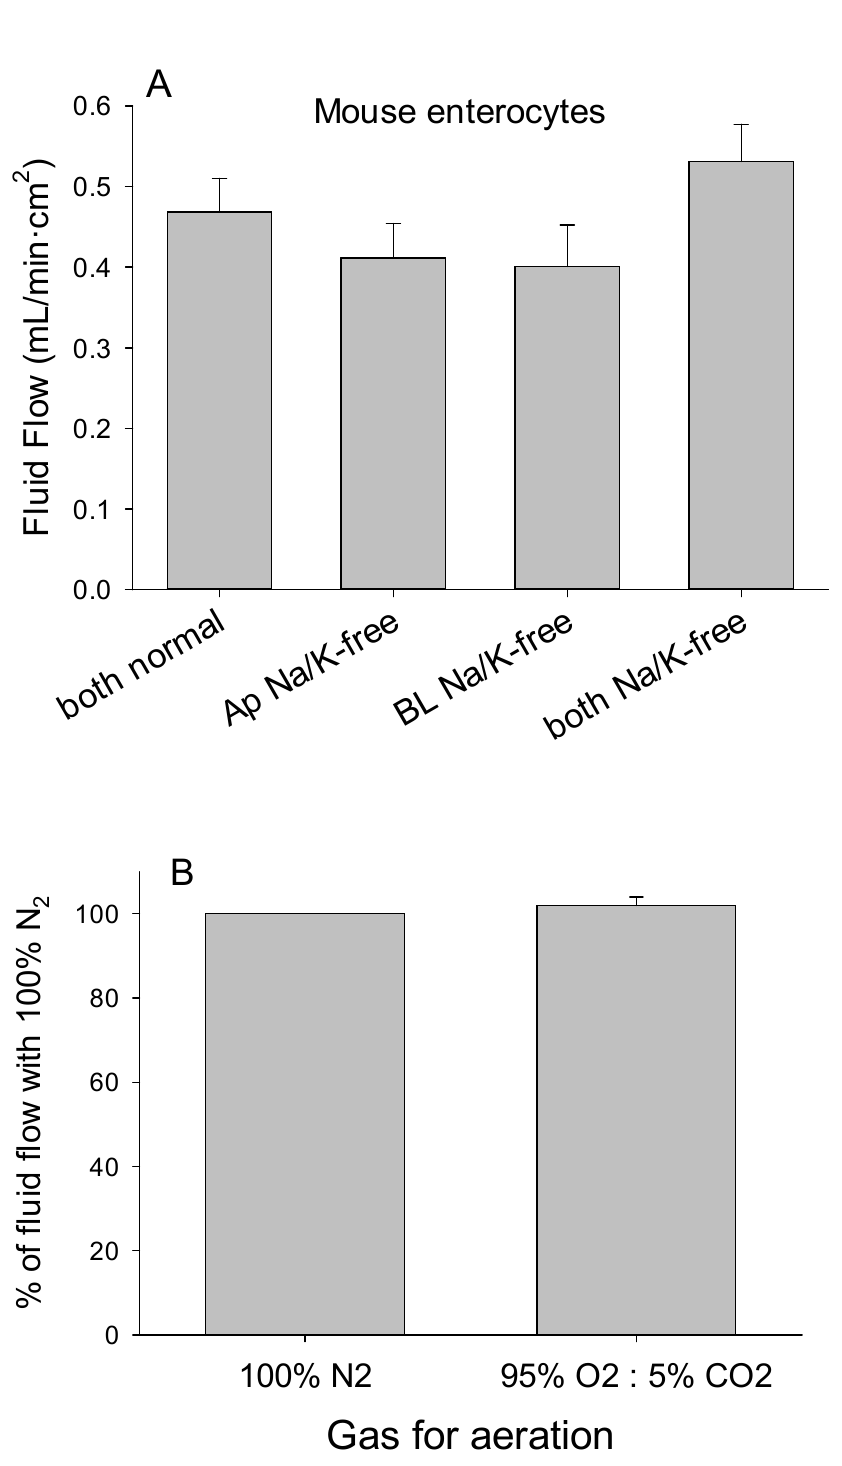
Figure 8. ( A ) Fluid flow by epithelia of mouse enterocytes cultured on inserts with 12 µm pores and exposed to vigorous aeration did not differ when both chambers were filled with normal Ringer’s solution (both normal) and when Na-free and K-free Ringer’s solution was added to the apical (Ap Na/K-free) or basolateral (BL Na/K-free) chamber or to both chambers (both Na/K-free). ( B ) Fluid flow by epithelia of enterocytes cultured on inserts with 12 µ m pores did not differ when exposed to vigorous aeration using 100% nitrogen or the mixture of 95% oxygen and 5% CO 2 . An even more striking indicator of the ion and osmotic independence of filtration secretion is how flow from the basolateral to the apical chamber was not hindered by fill- ing the apical chamber with diluted Ringer’s solution to impose a counter osmotic gradi- ent (Figure 9).